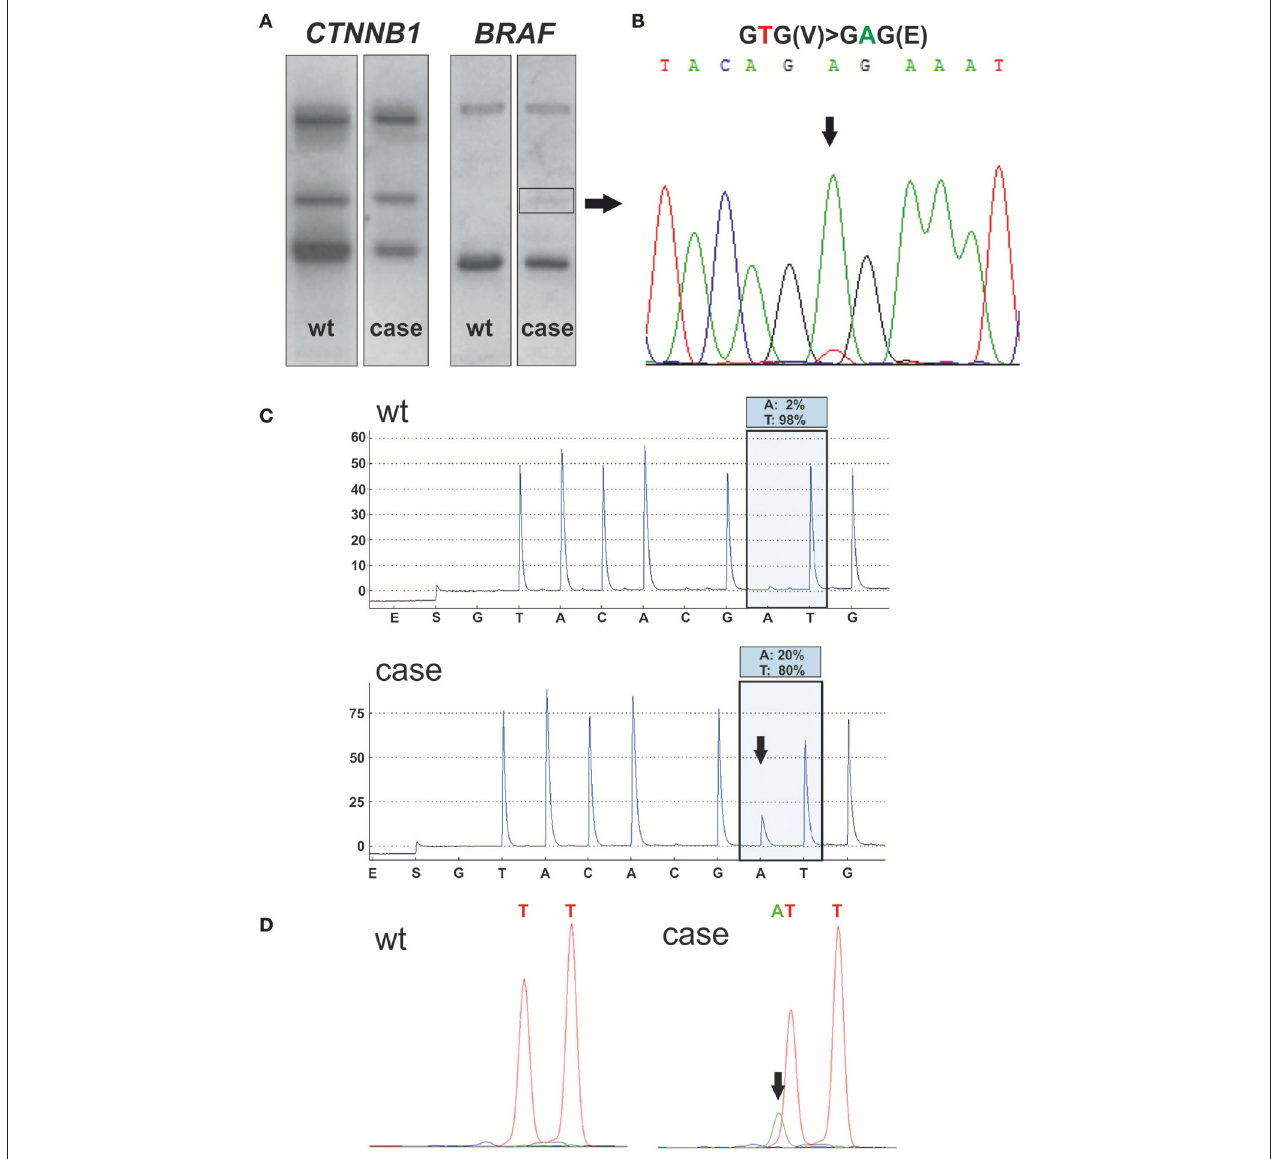
FIGURE 3 | Mutational analysis; SSCP analysis of the hot spot region of CTNNB1 (exon 3) and BRAF (exon 15) was performed using DNA extracted from the formalin fixed, paraffin embedded resected tissue of the child (case line) (A) . Wildtype DNA (wt line) was used as a control and to compare mutation induced aberrant bands. Only BRAF showed a shifted band (square), revealing in Sanger sequencing a BRAF V 600 E mutation with a thymine (T) to adenine (A) transversion (B) . Pyrosequencing (C) confirmed BRAF V 600 E mutation (allele frequency of A: 20%), compared to the wt control (allele frequency of A: 3%). Pyrosequencing was performed twice in the department of neuropathology and department of pathology with comparable results. SNapShot analysis (D) confirms thymine to adenine transversion (arrow) in relation to wt control, which leads to an amino acid exchange of valine to glutamic acid at codon 600 within the BRAF